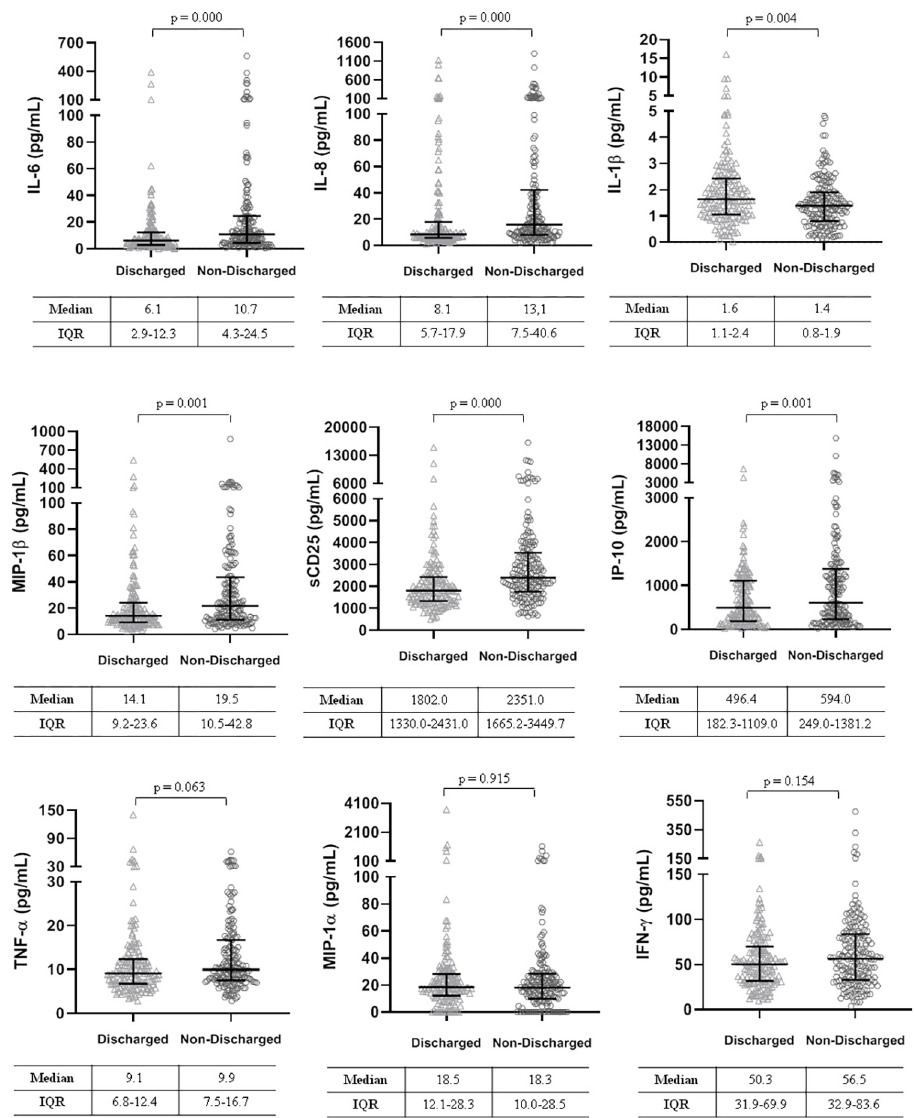
Fig 3. Differences in plasma cytokine concentrations at baseline in mild patients according to whether or not they were discharged during the first week of hospitalization. IL-6, interleukine-6; IL-8, interleukine-8; IL-1 β , interleukine-1 β ; MIP-1 β , macrophage inflammatory proteins 1 β ; sCD25, soluble receptor interleukine-2; IP-10, interferon γ -induced protein 10; TNF- α , tumor necrosis factor α ; MIP-1 α , macrophage inflammatory proteins 1 α ; IFN- γ ,